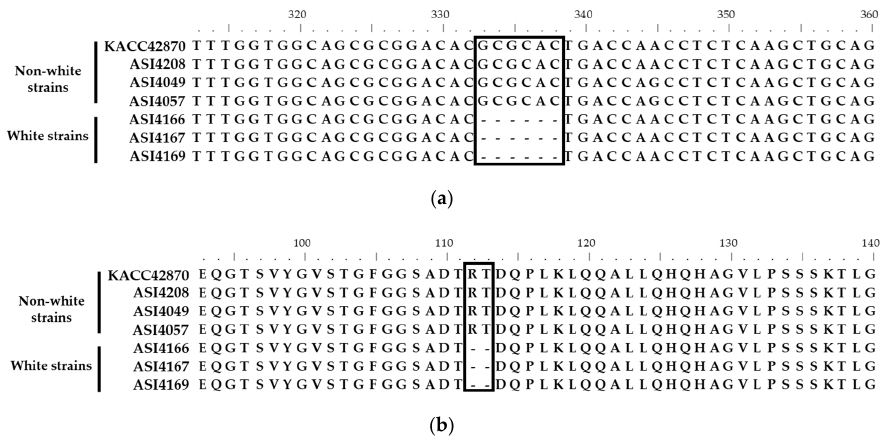
Figure 2. Alignments of phenylalanine ammonia ‐ lyase 1 ( Fvpal1 ) genes of Flammulina velutipes strains. ( a ) cDNA sequences; ( b ) amino acid sequences. Boxes indicate the variation sites of the Fvpal1 gene. The white strains of F. velutipes showed a deletion of GCGCAC ( 112 RT 113 ; arginine and threonine) in the Fvpal1 gene.